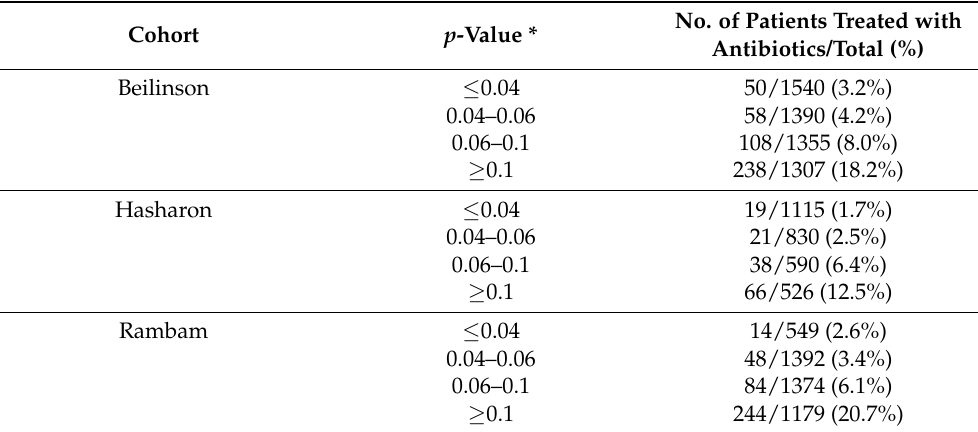
derivation cohort and the two validation